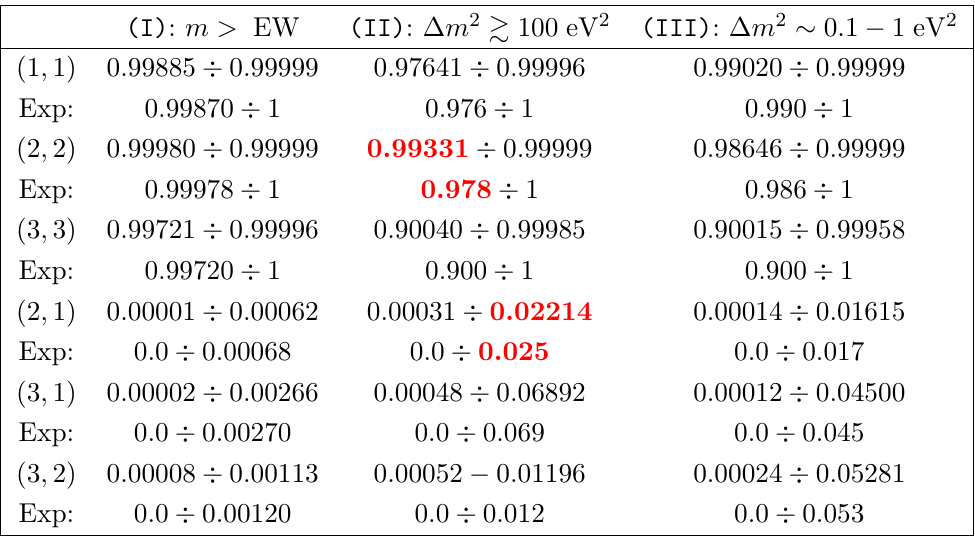
Table 4 . Lower and upper bounds for elements of the matrix T in the 3+1 scenario. For scenarios 3+2 and 3+3 we do not observe any changes of experimental limits given in table